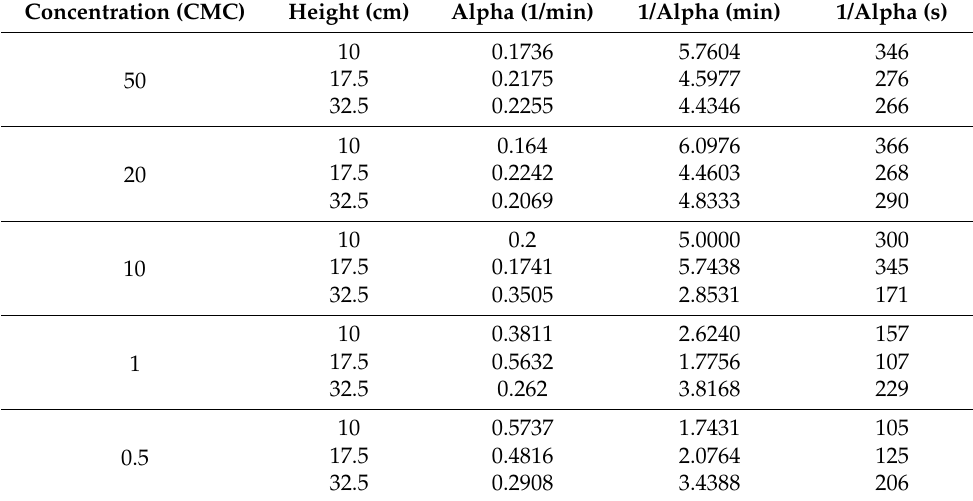
Figure 12. Average liquid volume fraction for whole foam against time for each concentration of SDS, where ( a ) is distilled water solutions and ( b ) is 15 dH hard water solutions. The fitting is according to Equation (3). Table 4. The characteristic time scale obtained using Equation (4) for foams produced with SDS solutions with distilled water for each of the heights